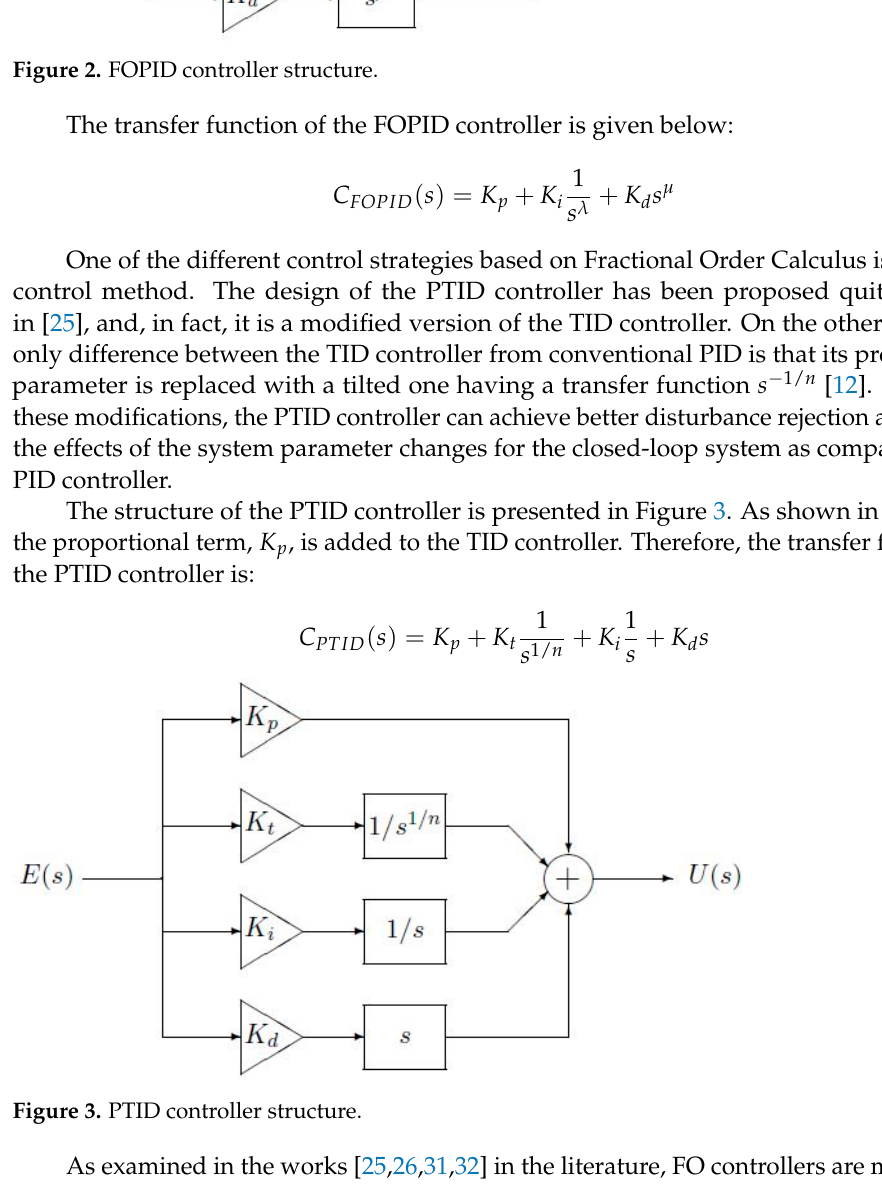
Figure 4. FOPTID controller structure. In this study, the effect of the FOPTID controller on the trajectory-tracking control of the robotic manipulator will be evaluated. In this regard, an efficient FOPTID controller can be obtained by tuning with the hybrid optimization algorithm GWO–PSO, which will be presented in the next section.